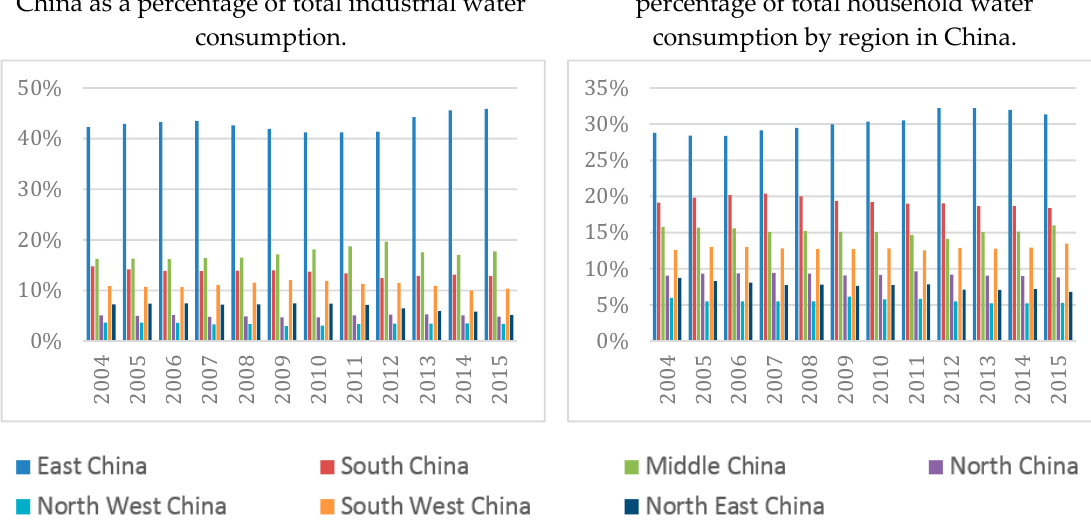
Figure 1. Water consumption in China by sector and by region.